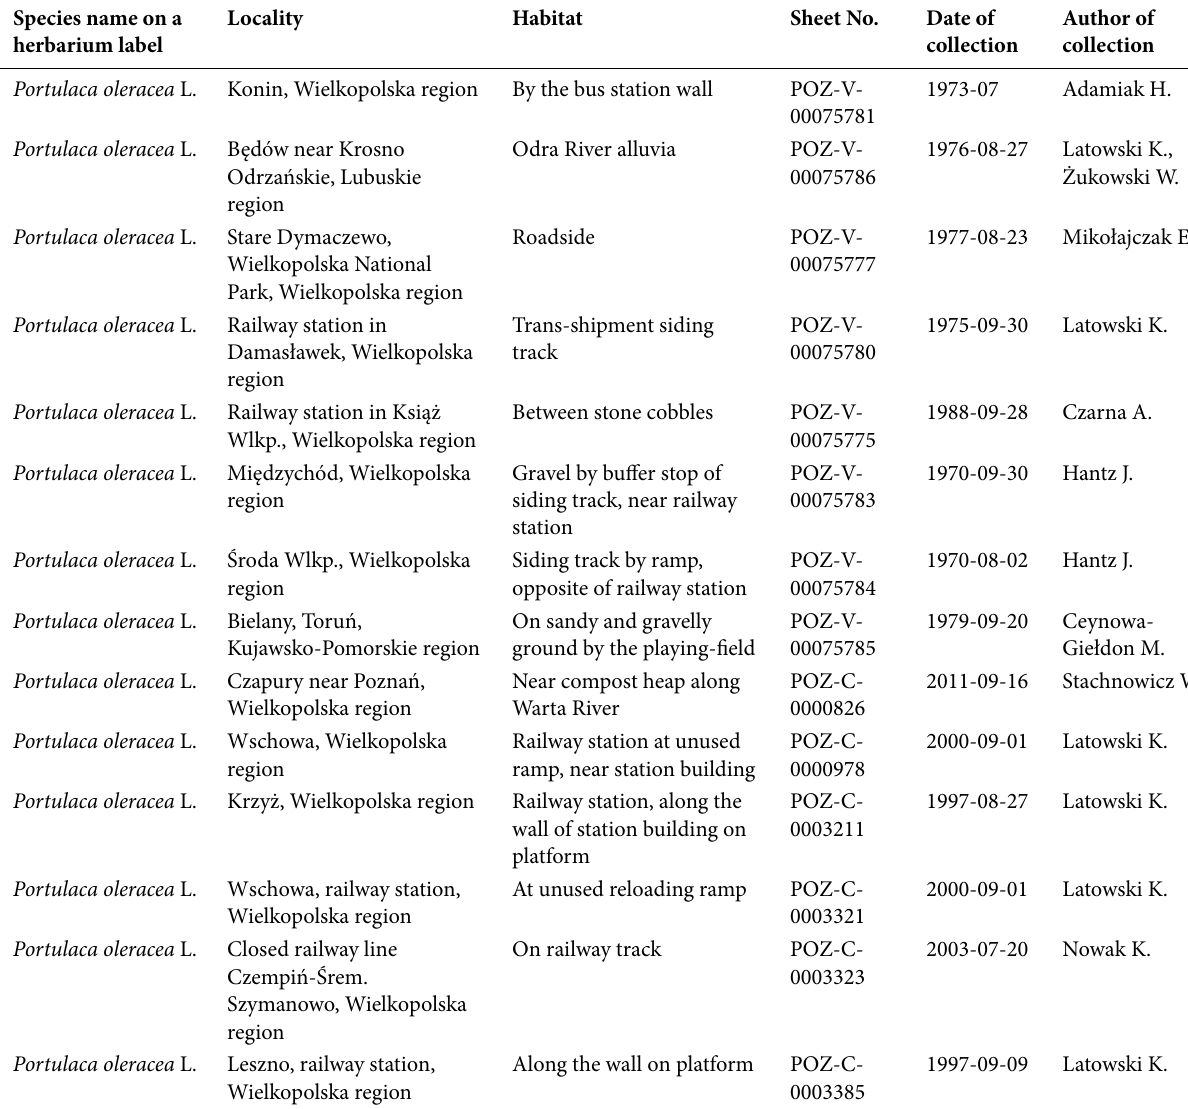
Table 1 Herbarium specimens of Portulaca oleracea aggr. deposited in the POZ